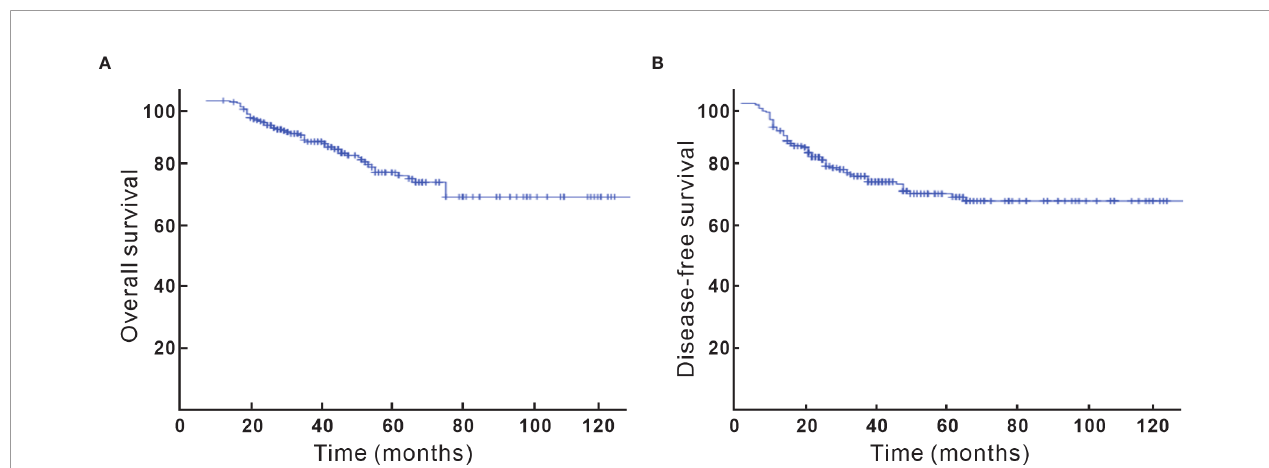
FIGURE 1 | (A) Overall survival. (B) Disease-free